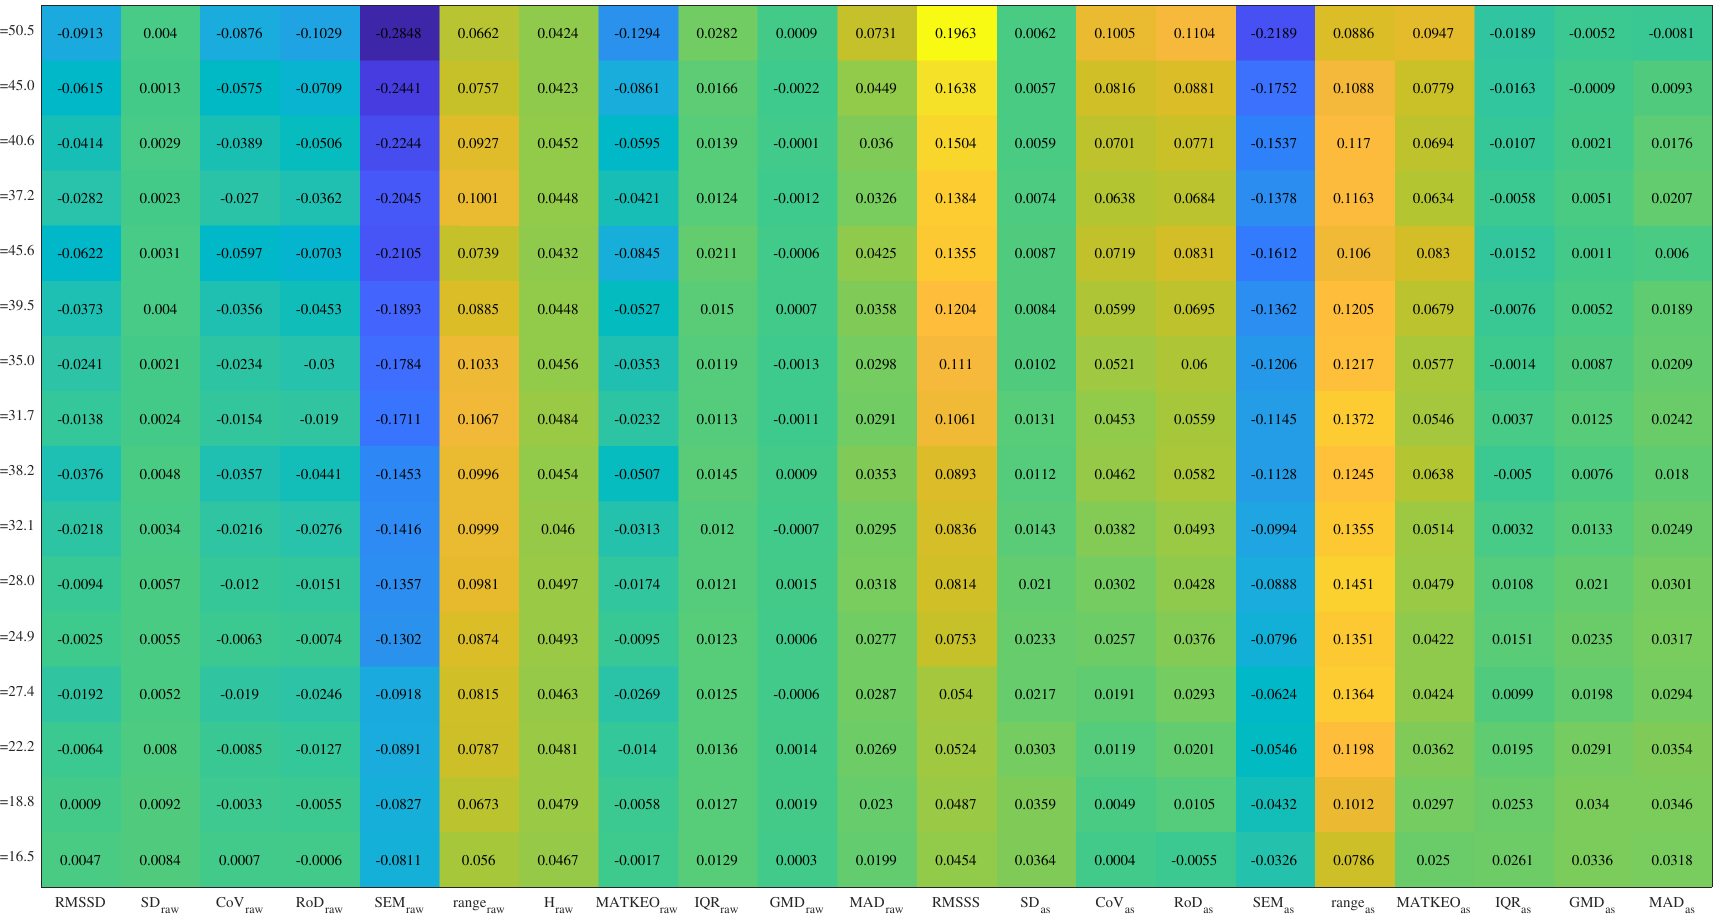
Figure 7. Results for 4000 reference subsequences obtained sampling observations with a Hawkes process of a cosine of amplitude 40, and then removing 70% of the observations. The colormap spans the full range. The meaning of all quantities can be found in the table of